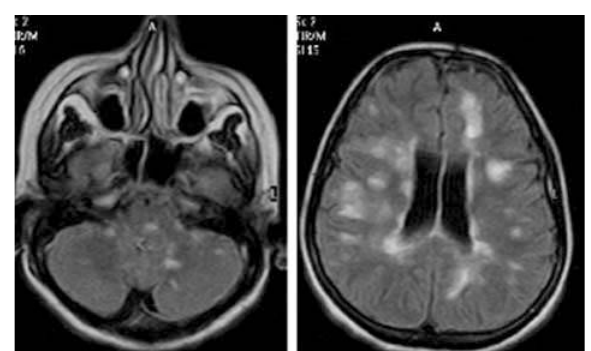
MRI scanning of the brain showing a posterior fossa cystic lesion, involving the fourth ventricle (FV). The lesion measured 5×7cm, insinuating through the foramina of FV into both cerebellopontine angles and below the